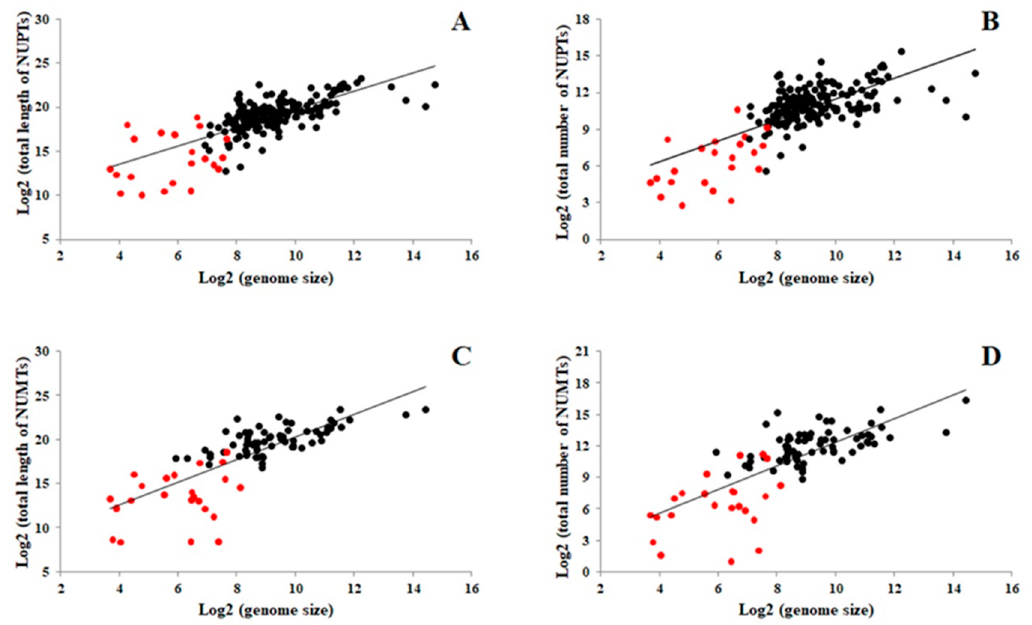
Figure 1. Correlation analysis between nuclear genome size and nuclear integrants of plastid DNA (NUPT)/nuclear integrants of mitochondrial DNA (NUMT) content or number in plants: ( A ) genome size versus cumulative length of NUPTs; ( B ) genome size versus total number of NUPTs; ( C ) genome size versus cumulative length of NUMTs; ( D ) genome size versus total number of NUMTs. This dot-plot was generated based on the data presented in Tables S1 and S2. The red dots indicate the results of algal plant analysis, whereas the black dots represent those of analysis involving other plants, most of which are flowering plants.